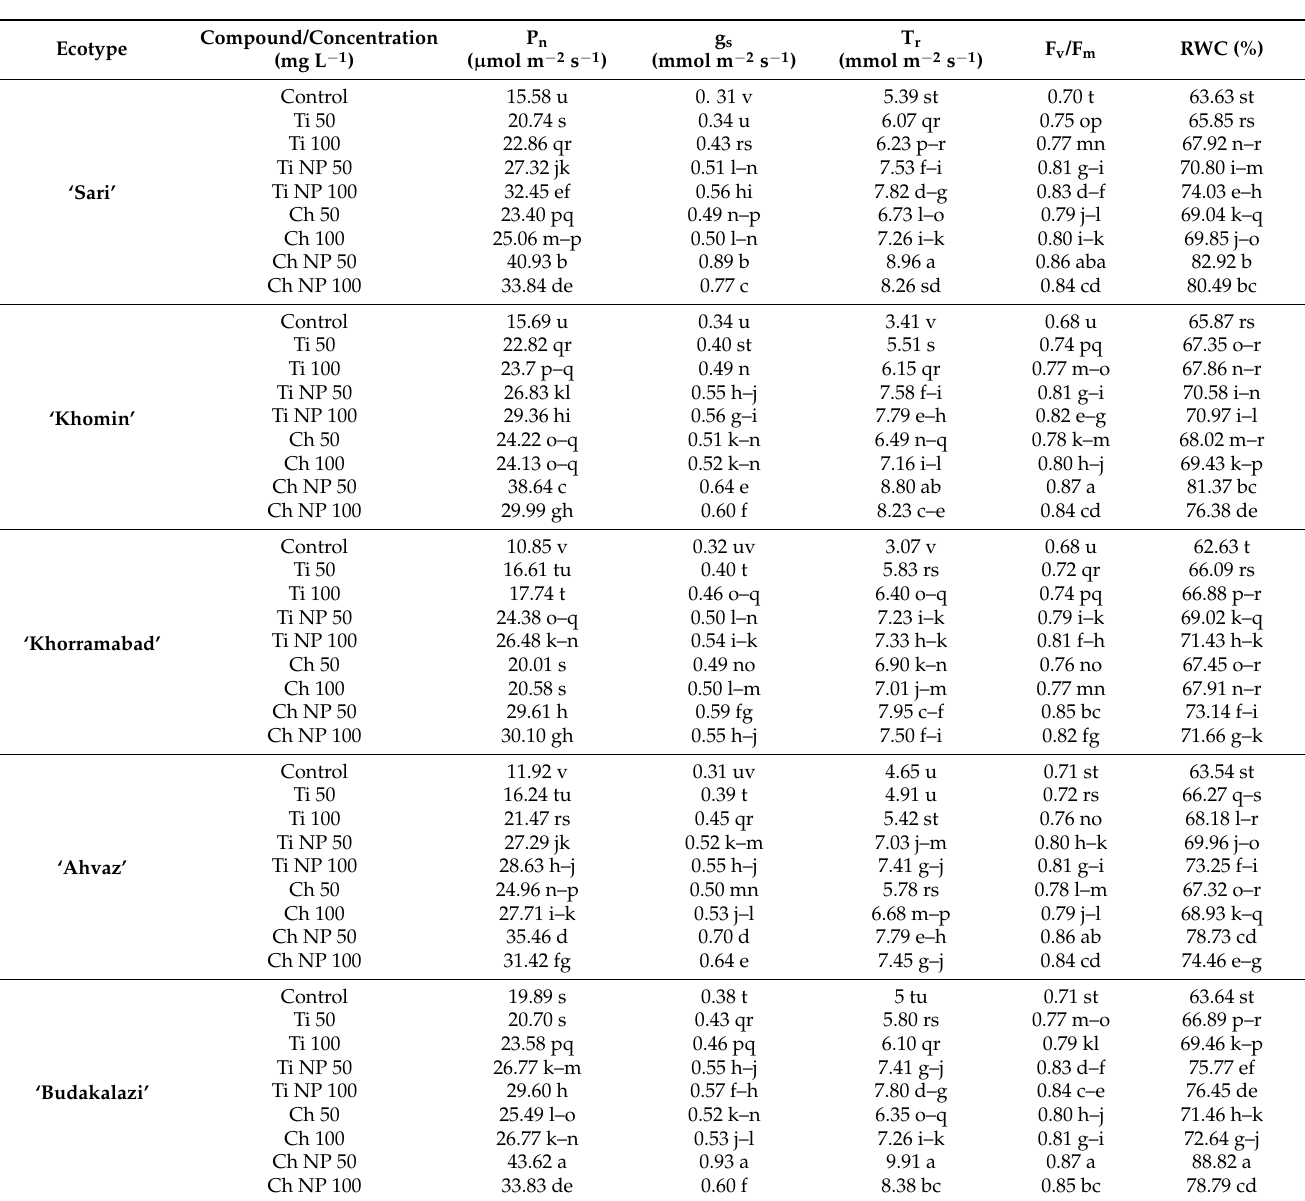
Table 7. Effects of chitosan and titanium dioxide (denoted as Ch and Ti, respectively) treatments [bulk, nanoparticle (NP)] applied at three concentrations (0, 50, and 100 mg L − 1 ) on leaf gas exchange, photosynthetic state, and hydration status of five milk thistle ecotypes. Three plants per treatment were assessed. Different letters within a column indicate statistically significant differences ( p < 0.05). In parameters (P n , g s , T r , and F v /F m ) showing significant interaction effects among all three factors involved (ecotype × treatment × year); a comparison of year means is provided in Tables S2 and S3. P n , net photosynthetic rate; g s , stomatal conductance; T r , transpiration rate; F v /F m , ratio of variable to maximum fluorescence; RWC, relative water